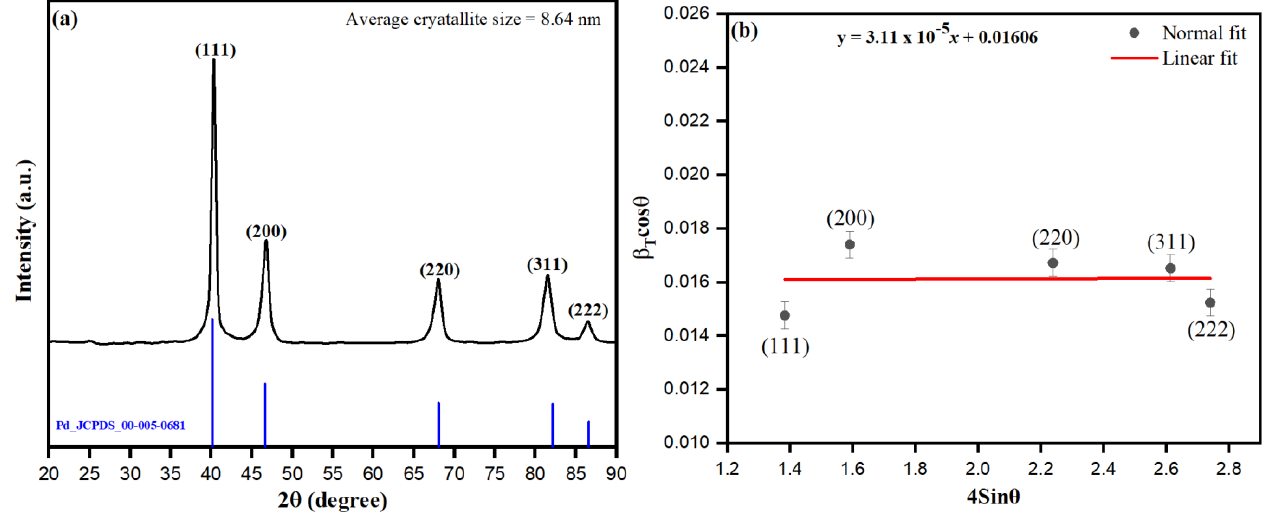
Figure 4. ( a ) XRD pattern for the PdNPs, ( b ) Williamson-Hall plot of PdNPs. Table 1. XRD parameters, including d-spacing, crystallite size, dislocation density, and micro-strain of PdNPs. Peak Position 2θ ( Degree)